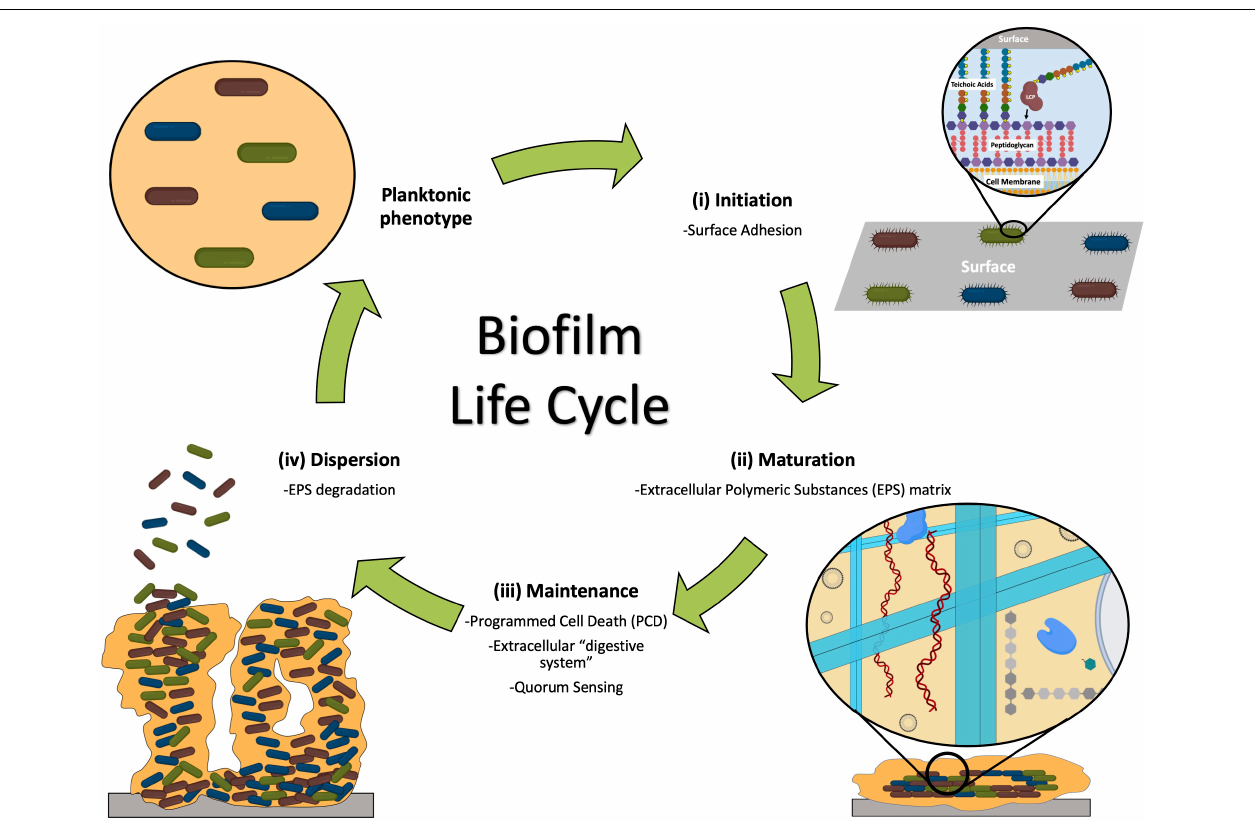
FIGURE 1 | The three stages of biofilm formation and main events involved: (i) initiation, when bacteria attach to the surface; (ii) maturation, when microcolonies are formed, adhered to the surface and embedded by the EPS matrix; and (iii) dispersion, when some members of the community are released from the biofilm entering the planktonic phenotype. Maintenance of the biofilm ensures the community survival (Vasudevan, 2014).